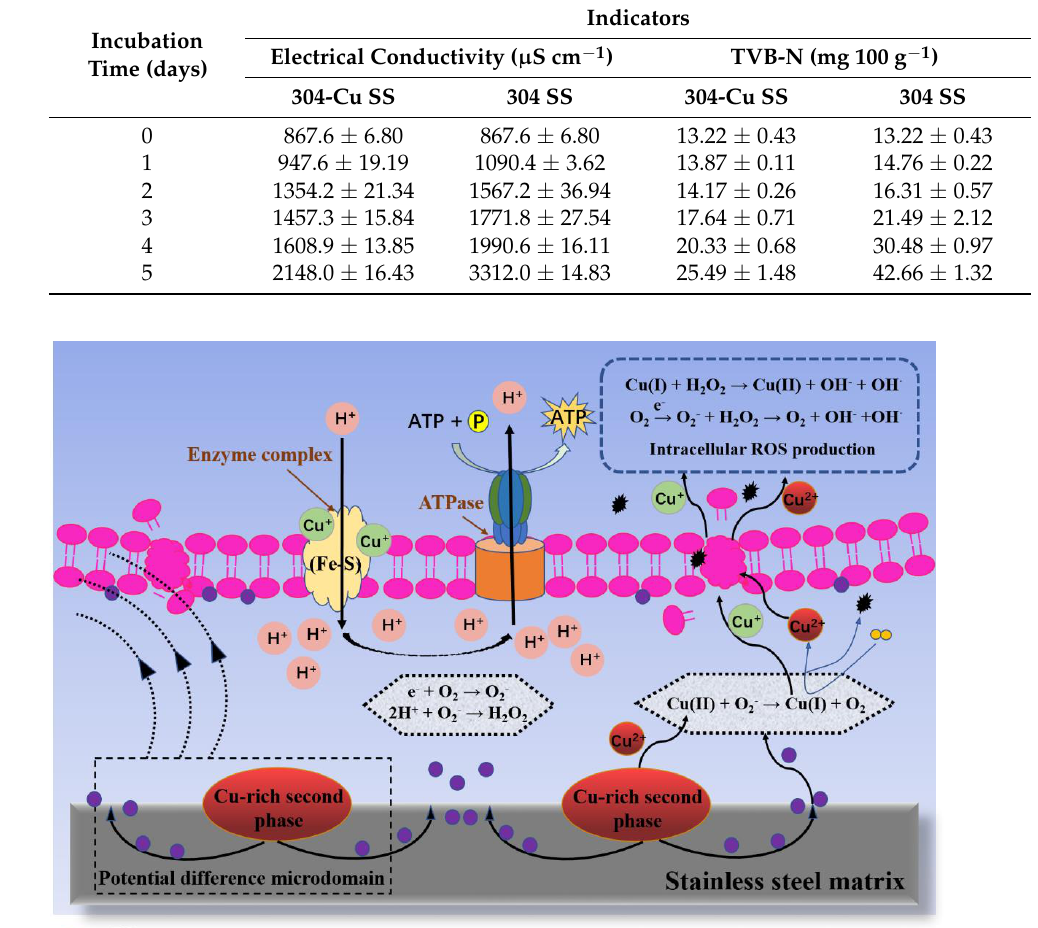
Figure 7. ( a ) Sensory changes in chicken meat spread out on antibacterial 304-Cu and ordinary 304 stainless-steel sheets, respectively; red arrows indicate the areas where the mucus obviously over- flowed. ( b ) Changes in total bacterial count of chicken spread out on antibacterial 304-Cu and ordi- nary 304 stainless-steel sheets [79]. Table 1. Changes in electrical conductivity and TVB-N of chicken meat spread out on antibacterial 304-Cu and ordinary 304 stainless-steel sheets [79].